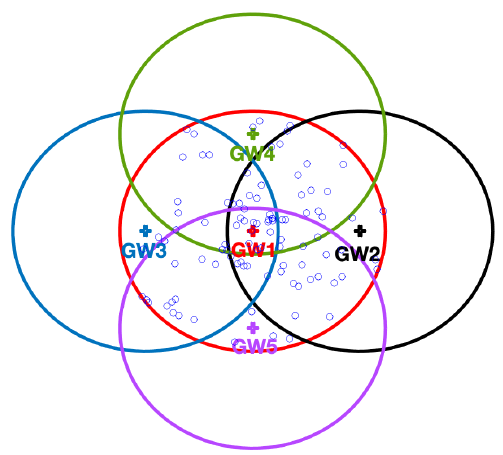
Figure 3. LoRa network with 5 gateways, GW1, GW2, GW3, GW4, and GW5, represented by red, black, blue, green, and purple crosses, respectively, and 100 EDs, represented as blue